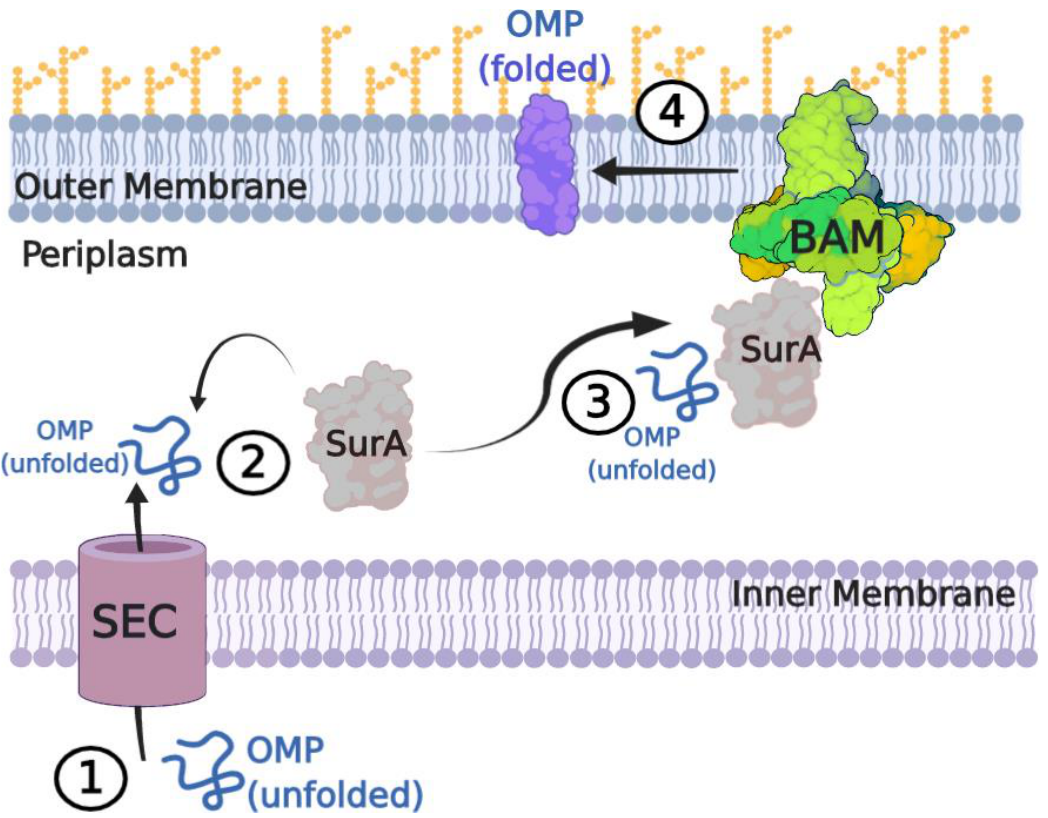
Figure 1. The β -OMP biogenesis pathway in Gram-negative bacteria. (1) Nascent β -OMPs are synthesized in the cytoplasm with an N-terminal signal sequence that routes them through the Sec translocon into the periplasm. (2) Periplasmic chaperones (e.g., SurA, Skp) stabilize the nascent β - OMPs to prevent misfolding or aggregation. Misfolded proteins that cannot be rescued are degraded by DegP to prevent toxicity. (3) The periplasmic chaperones then deliver the nascent β -OMPs to BAM, with SurA being the primary chaperone pathway. (4) BAM then folds and inserts the β -OMPs into the membrane using a mechanism which utilizes a hybrid-barrel intermediate with the barrel domain of BamA. This figure was prepared using BioRender.